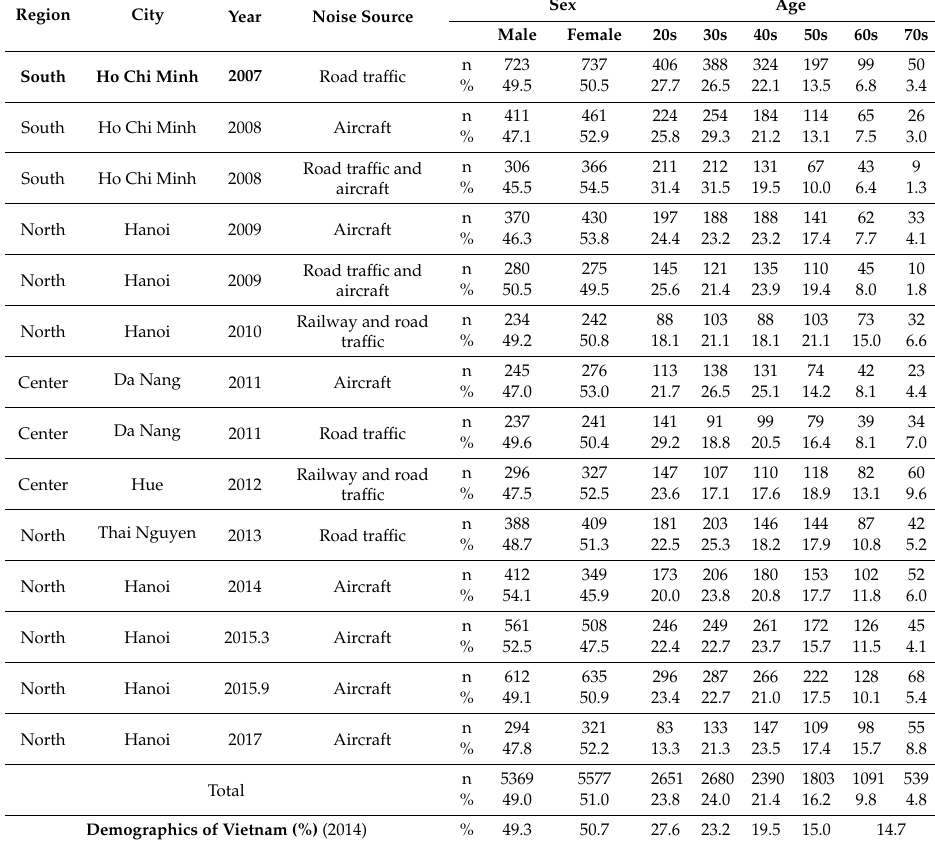
Table 7. Respondents’ demographic